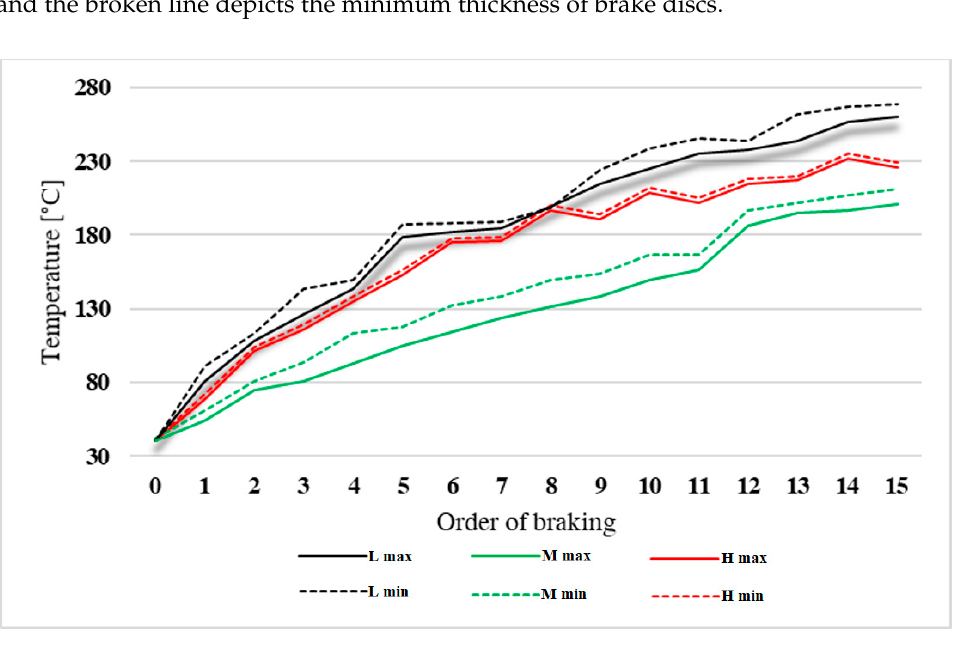
Figure 8. Brake discs’ temperature during repeated braking 15 times in a